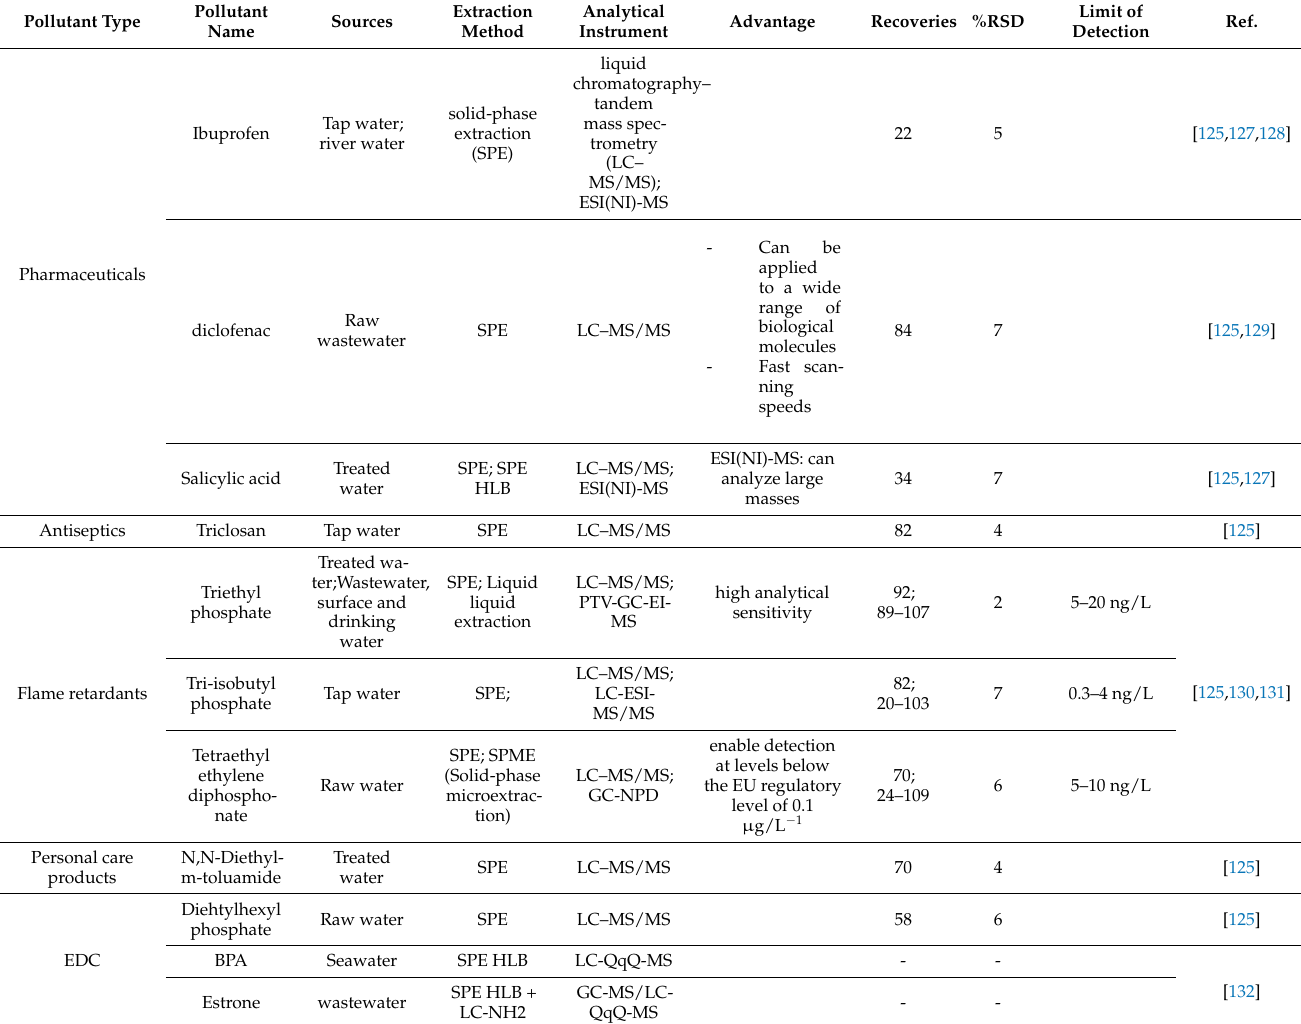
Table 4. Analytical methods used for quantitative analysis of emerging